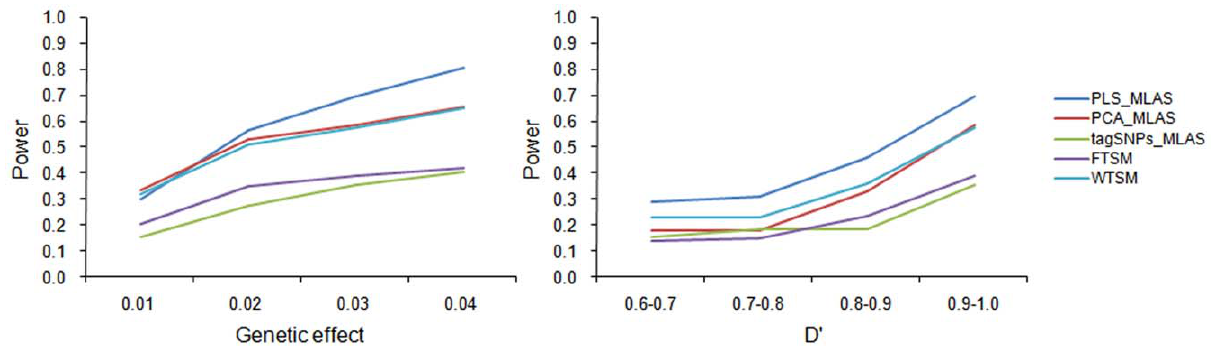
Figure 2. Power comparing results of PLS-based MLAS (PLS_MLAS), PCA-based MLAS (PCA_MLAS), tagSNPs-based MLAS (tagSNPs_MLAS), TSM-based MLAS using F test (FTSM) and TSM-based MLAS using Wald test (WTSM) under the additive model.